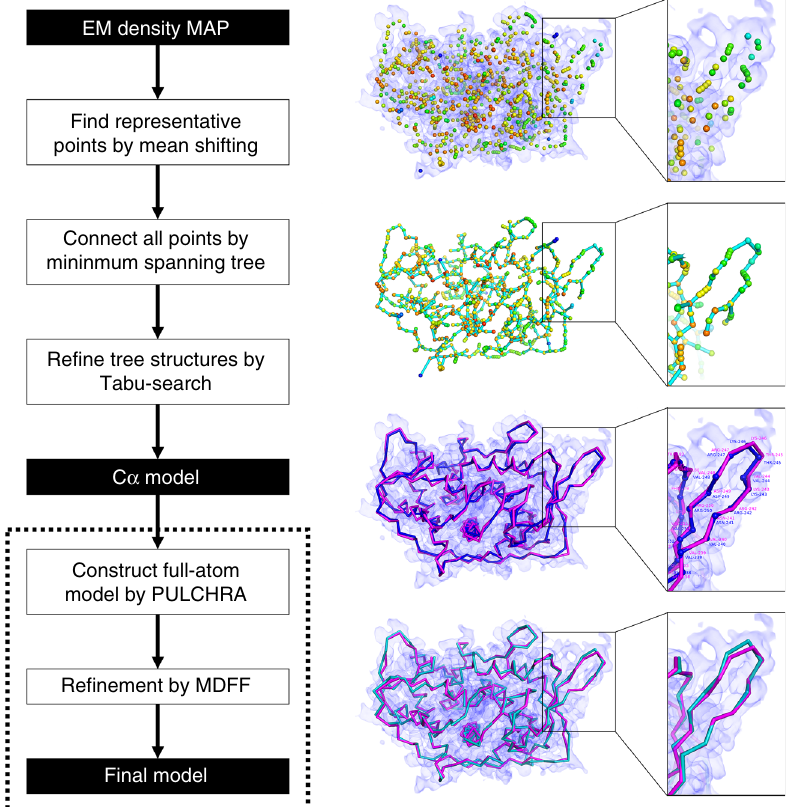
Fig. 1 Flowchart of MAINMAST. Steps of the MAINMAST algorithm is illustrated with a modeling example for an EM density map of structural protein 5 of cytoplasmic polyhedrosis virus solved at a 2.9 Å resolution (EMD-6374). First, points with high local density are identi fi ed with the mean shift algorithm. The color scale of the points indicate density, blue to orange for low to high density. Identi fi ed local dense points are connected by minimum spanning tree (MST) (cyan). Using tabu-search, the initial MST is re fi ned and a few thousands of alternative MSTs are generated. For each MST, the amino acid sequence of the query protein is mapped on the longest path in the tree by matching the volume of amino acids to the density of the local dense points (threading). C α models from each MST are ranked with the density – volume matching (threading) score. In the third panel on the right, the blue chain represents a C α model and the structure in magenta is the native structure. Selected C α models are re fi ned with a sequential application of PULCHRA and MDFF to obtain fi nal full-atom models